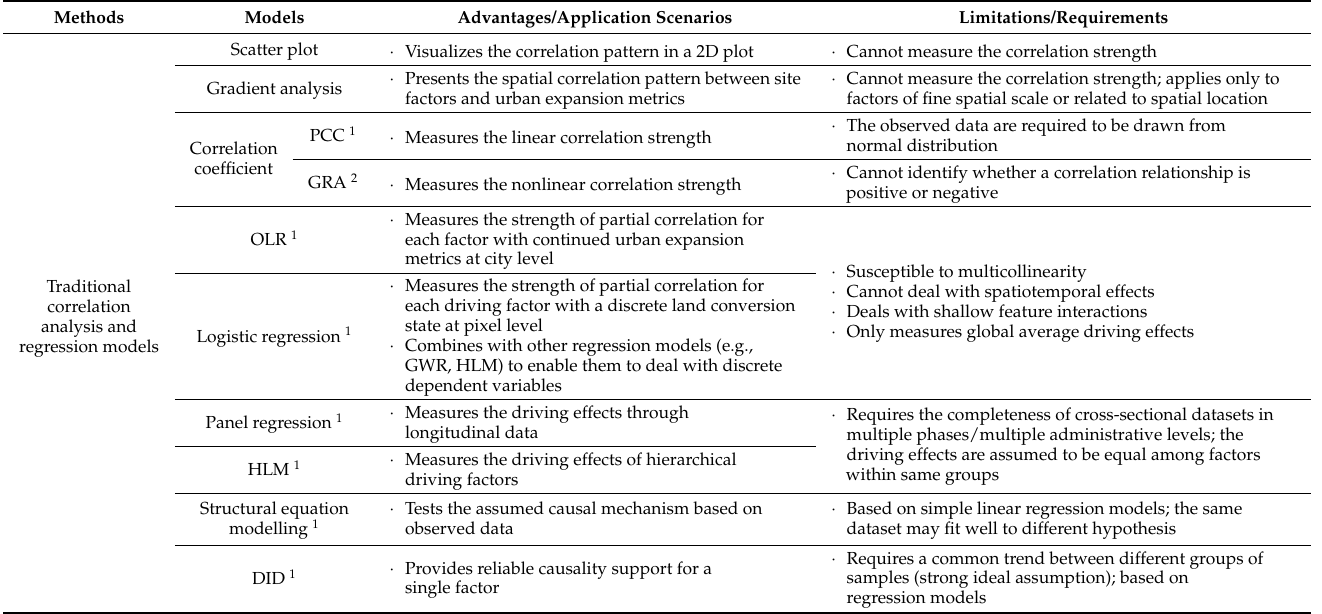
Table 4. Characteristics of quantitative models employed in